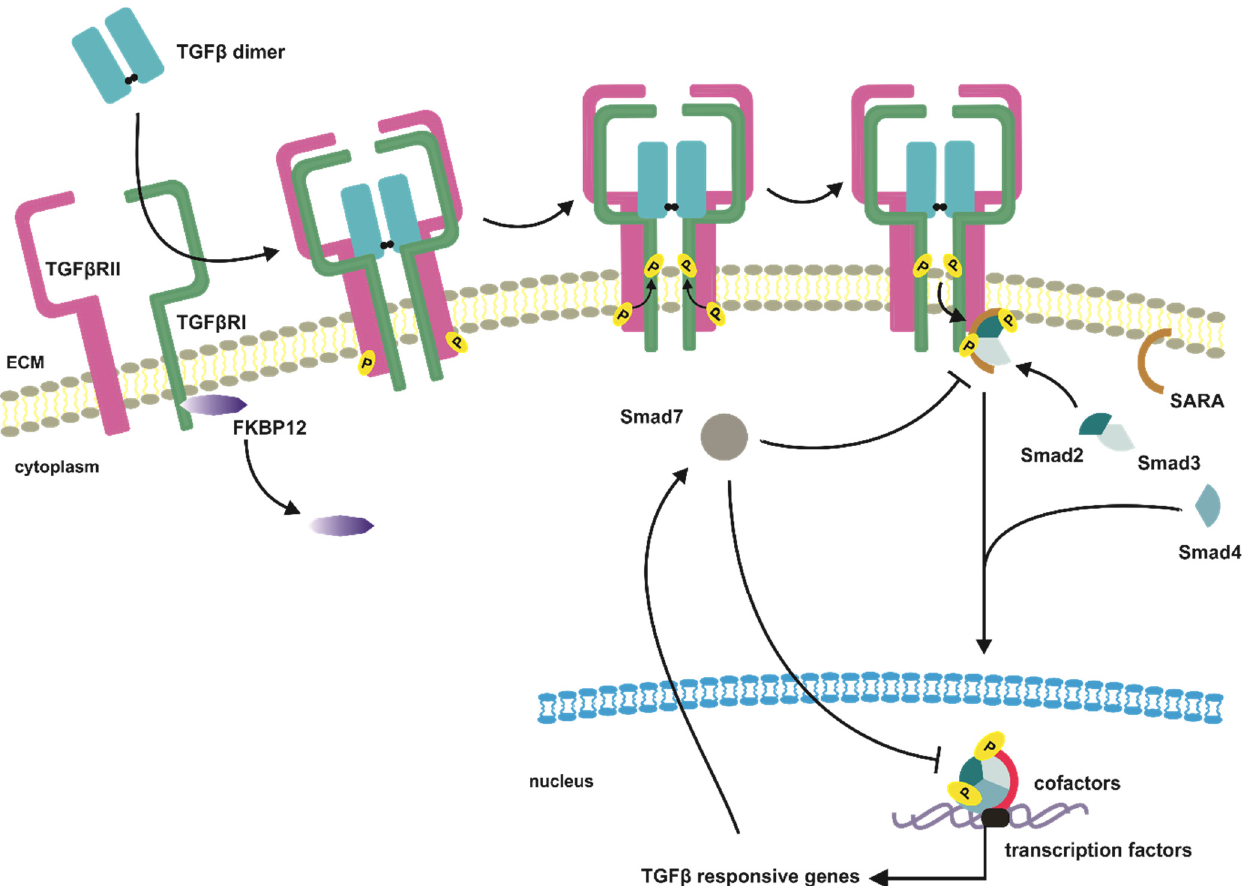
Figure 2. Canonical TGF β pathway. The first step in TGF β canonical pathway is an interaction of the dimeric TGF β ligand with a tetrameric receptor complex consisting of two pairs of TGF β RIs and TGF β RIIs. The activated dimer of TGF β RIIs due to its constitutive kinase activity phosphorylates TGF β RIs. The ligand-induced activation of TGF β RIIs with following phosphorylation of TGF β RIs results in release from TGF β RI an inhibitory FKBP12 protein, what promotes the activation of TGF β RI kinase domains. The signal propagation occurs when activated TGF β Rs tetramer phosphorylates cytoplasmic Smad2/3 proteins complex. The SARA protein stabilizes the interaction of Smad2/3 complex with TGF β RIs. An activated Smad2/3 complex translocates to the nucleus, and together with Smad4 and other transcription factors and/or cofactors, activate an expression of TGF β responsive genes. Smad7 antagonizes TGF β induced signaling by an association with the activated TGF β RI receptor, thus blocking an interaction, activation, and phosphorylation of Smad2 effectors. Smad7 can also disrupt the Smad-DNA complex formation in the nucleus, thereby altering cell responsiveness to TGF β at the transcriptomic level. FKBP12: immunophilin 12-kD FK506 binding protein; SARA: Smad anchor for receptor activation.